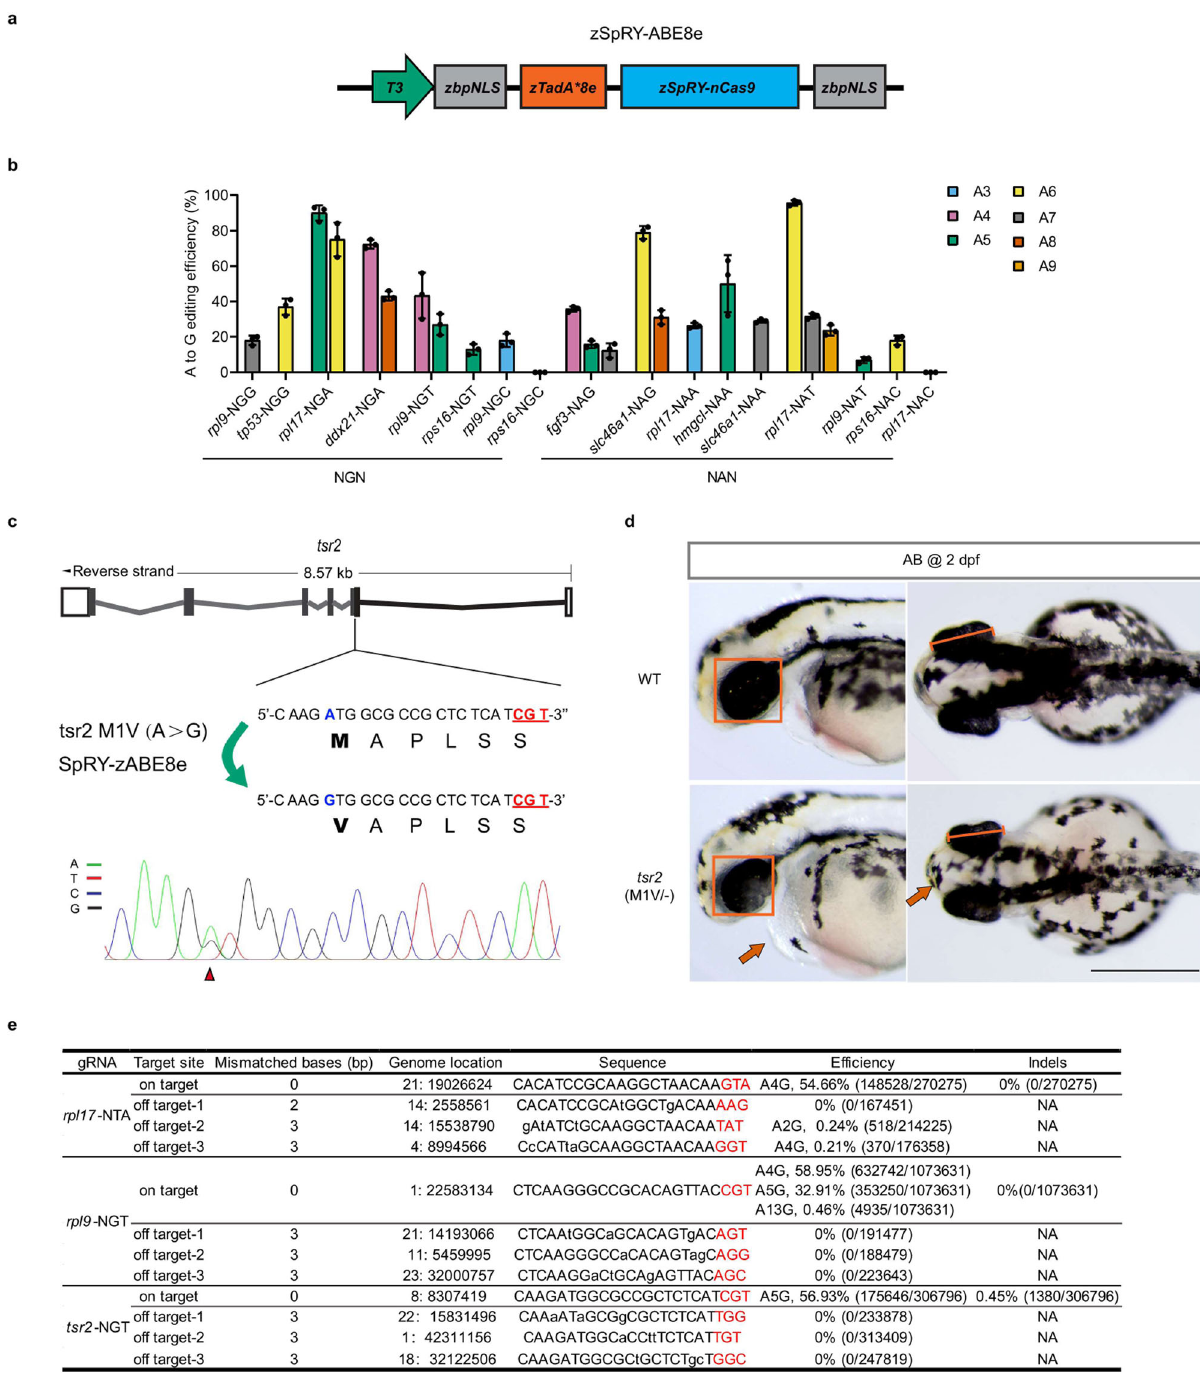
Fig. 4 Ef fi cient adenine base editing mediated by zSpRY-ABE8e across various PAMs. a The mRNA construct of zSpRY-ABE8e used for adenine base editing in zebra fi sh. b Summary of A-to-G base editing ef fi ciency of various loci with NRN PAMs induced by zSpRY-ABE8e editor in zebra fi sh. The position of editing base in the gRNA was labelled with numbers. (Values are presented as mean value ± standard deviation (SD), n = 3 biological replicates.) c Schematic diagram and sequencing results of tsr2 (M1V) mutation induced by zSpRY-ABE8e in zebra fi sh. The PAM sequences are underlined in red, the detected nucleotide changes are highlighted in blue, the targeted amino acids are highlighted in bold, and the nucleotide substitutions are indicated with a red arrowhead in the sequencing chromatograms. d Morphological phenotype of tsr2 ( M1V )/ − -de fi cient embryos at 2 dpf. The comparison of eye size is underlined with a red frame in the lateral view and with diameter measurement in the dorsal view. Red arrows indicate a pointy head and slight pericardial oedema of tsr2 ( M1V )/ − mutants. Scale bar: 500 μ m. This experiment was repeated three times independently with similar results. e On-target, product purity and off-target analysis of zSpRY-ABE8e induced A-to-G editing at rpl17 -NTA, rpl9 -NGT and tsr2 -NGT sites using NGS. The PAM sequences are underlined in red. NA: Not Applicable. All source data in this fi gure are provided as a Source data fi le.